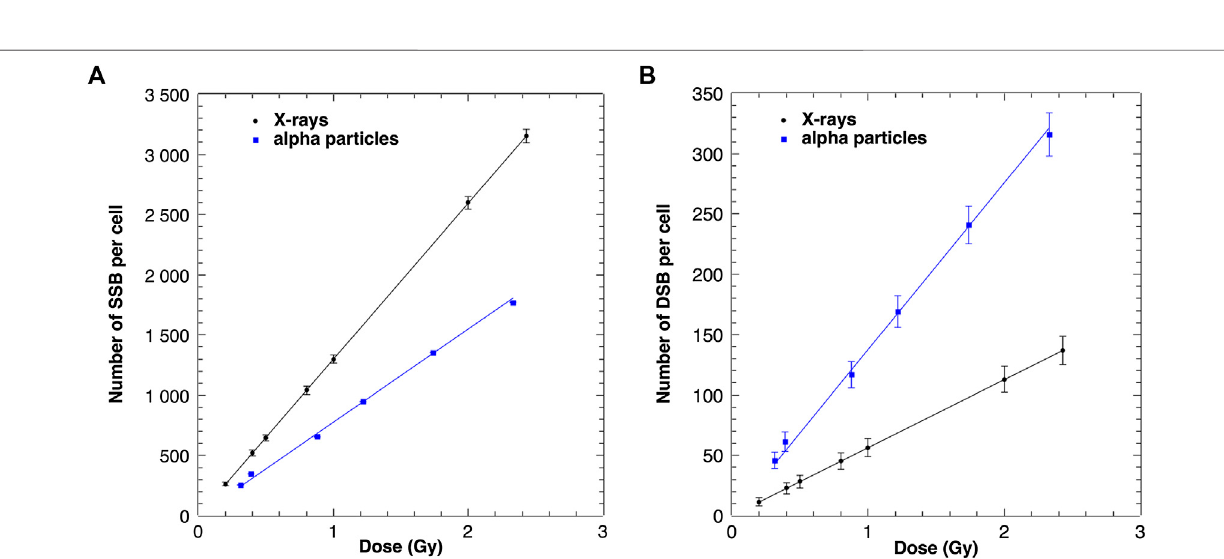
FIGURE 2 | Modeled numbers of SSB (A) and DSB (B) induced in a cell nucleus after X-ray and alpha particle irradiation as a function of the absorbed dose. The uncertainties are given as standard deviations.